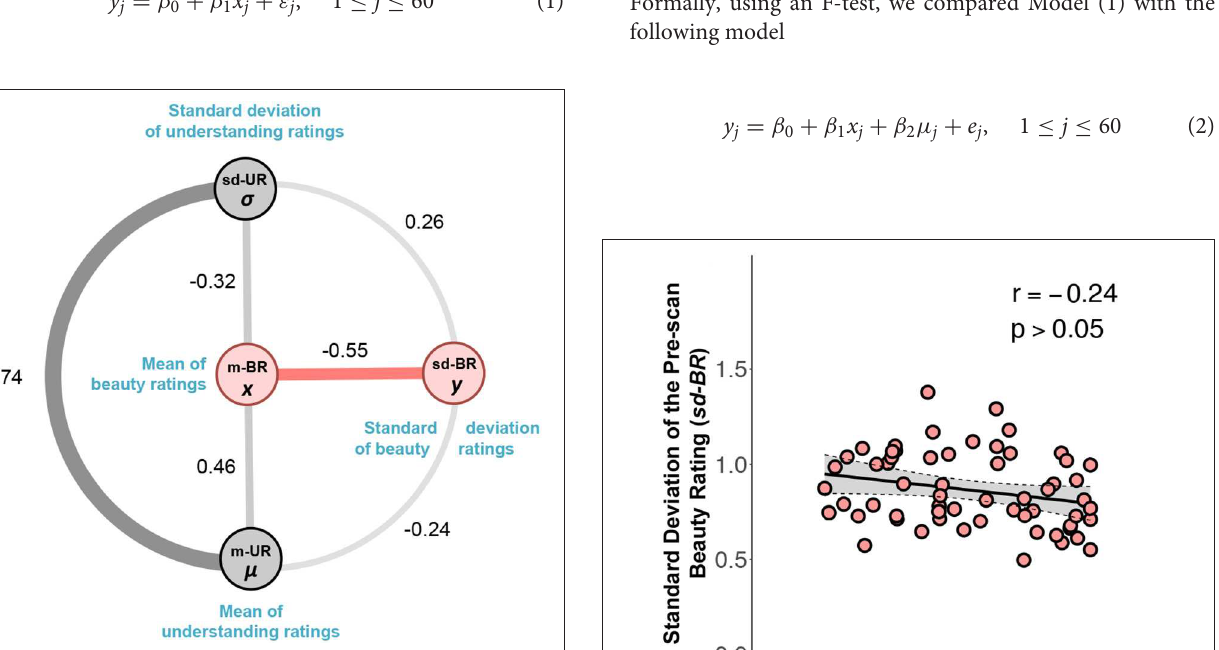
FIGURE 3 | A schematic representation of the association between mean beauty ratings (m-BR), mean understanding ratings (m-UR), the standard deviation of understanding ratings (sd-UR) and standard deviations of beauty ratings (sd-BR). The thickness of the connecting lines denotes the pairwise Pearson correlations between them. We show below that although there is an association between m-BR and m-UR, there is no association between m-UR and sd-BR. Moreover, adding m-UR to m-BR does not improve the established association between m-BR and sd-BR.